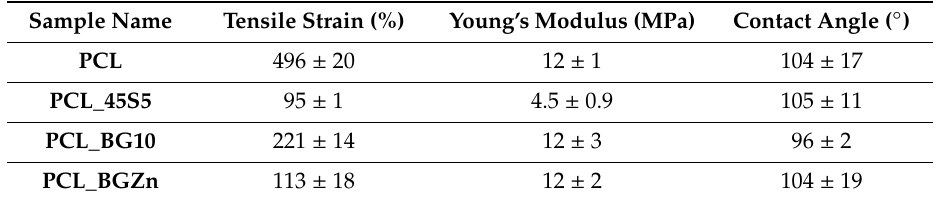
Table 3. Tensile strain, Young´s modulus and contact angle values for PCL, PCL_45S5, PCL_BG10, and PCL_BGZn.